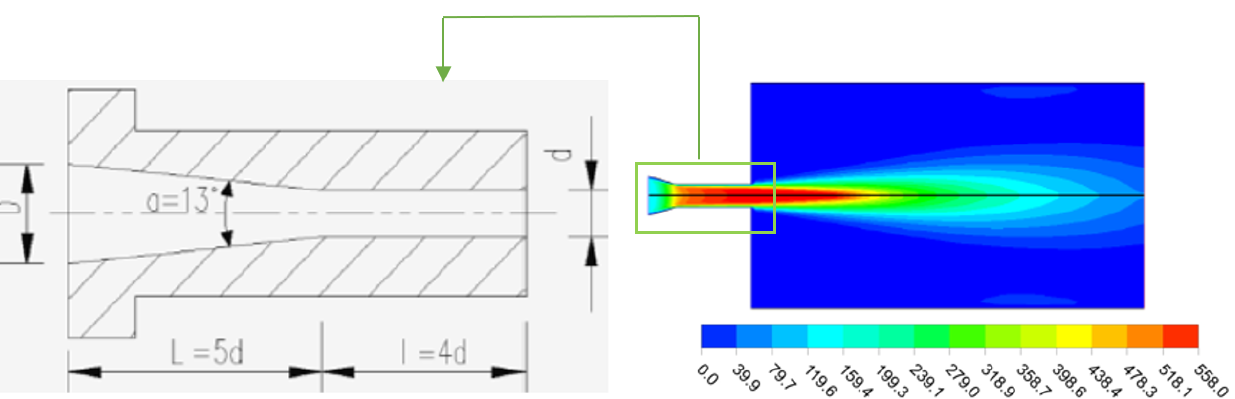
Figure 21. Different kinds of nozzle being studied and respective performance [83].